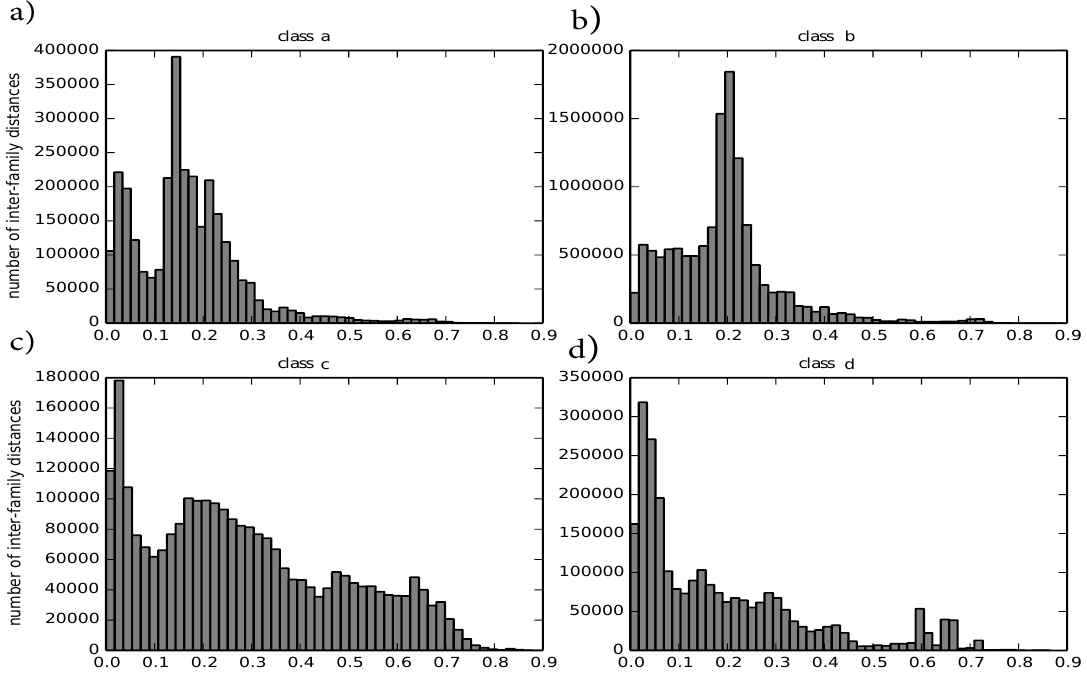
Figure 3. Histograms of intra-family distances divided by class: ( a ) corresponds to class a; ( b ) corresponds to class b; ( c ) corresponds to class c; ( d ) corresponds to class